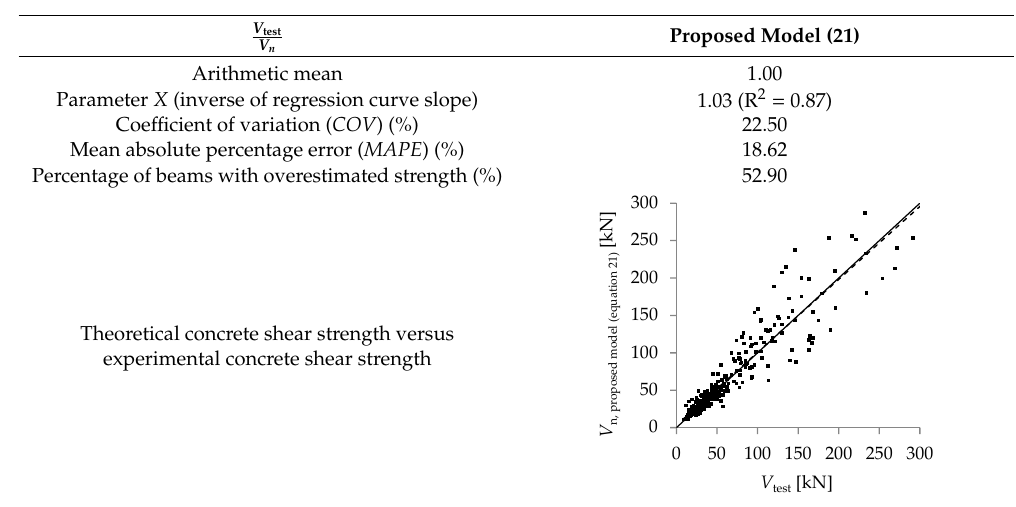
Table 5. Comparison of experimental ( V test ) and theoretical ( V n ) values of the concrete shear strength for the proposed model.